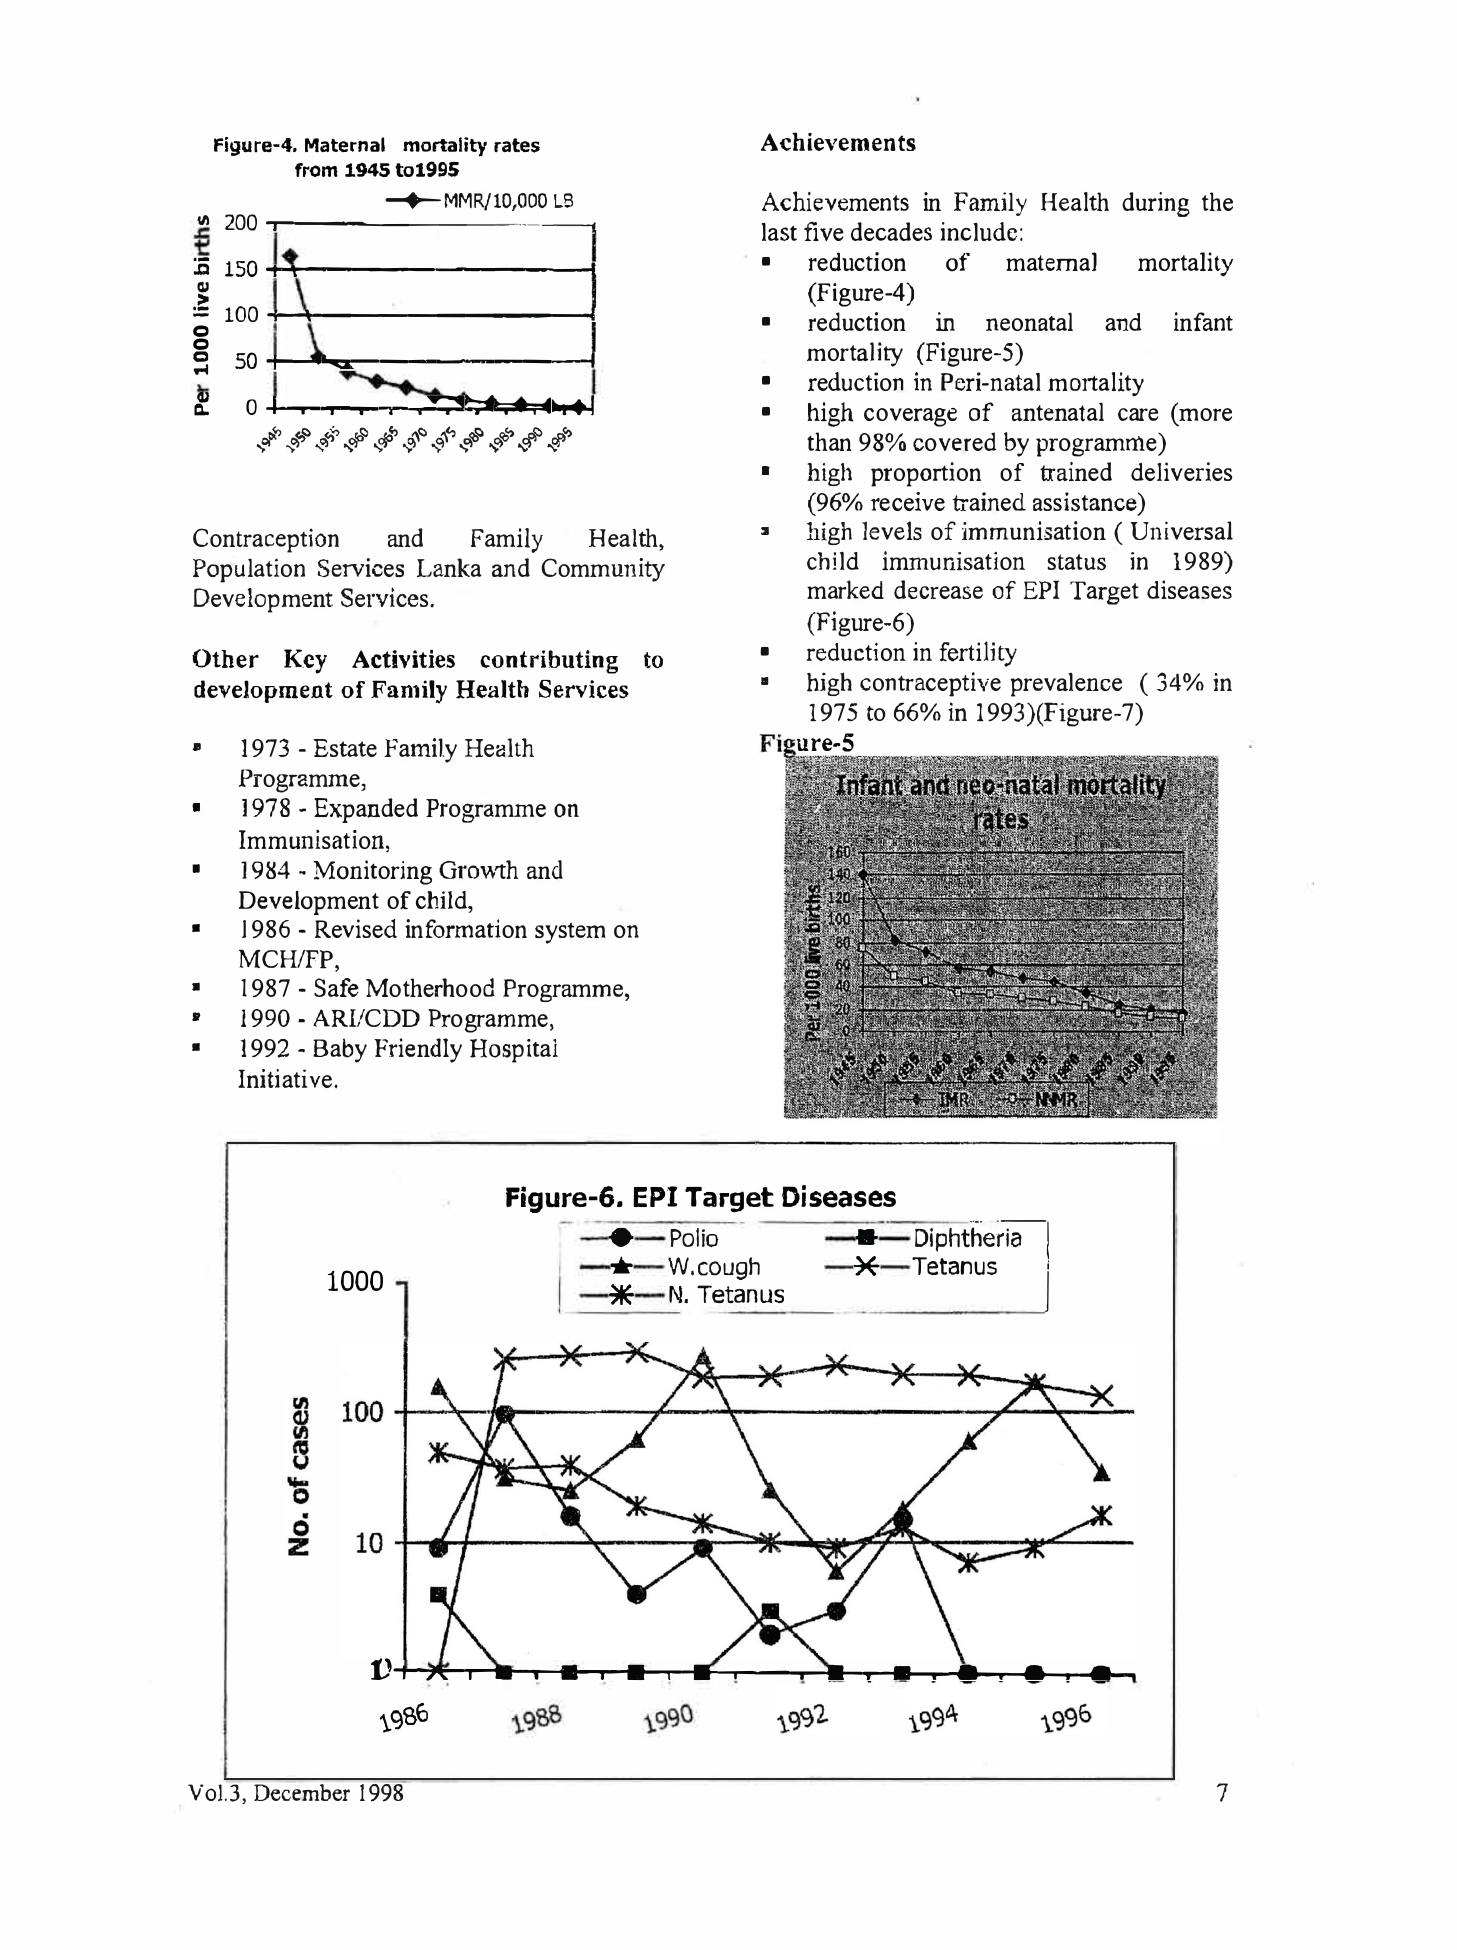
Figure-6. EPI Target